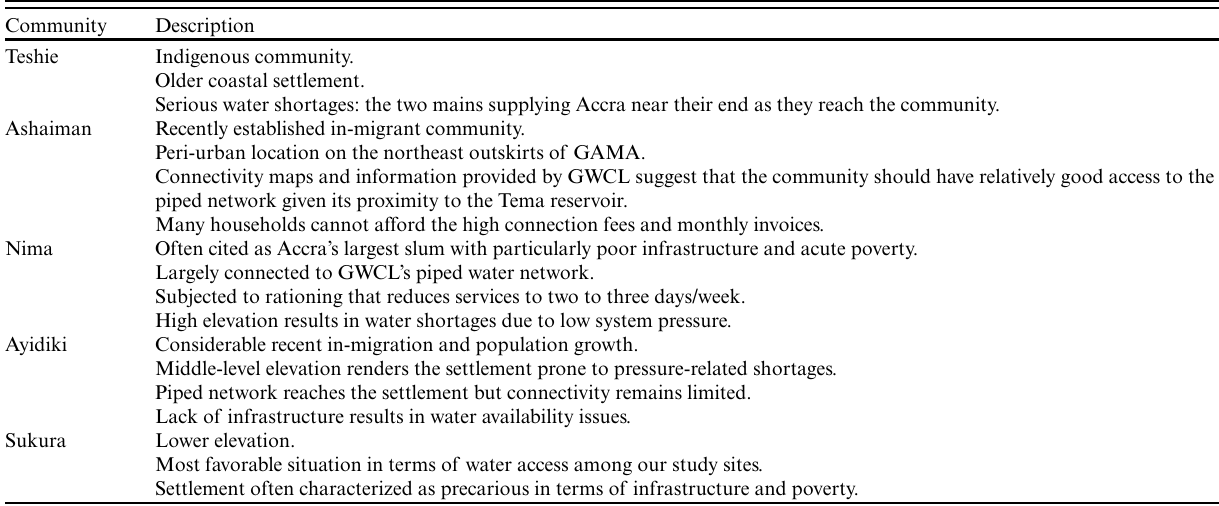
Table 1 . Communities